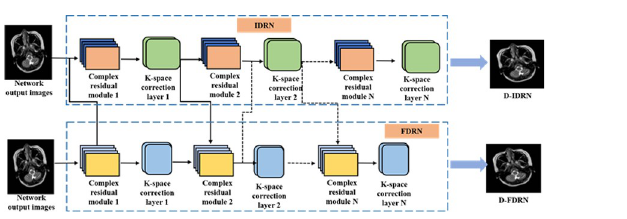
Fig 2. A dual-domain reconstruction model of MRI